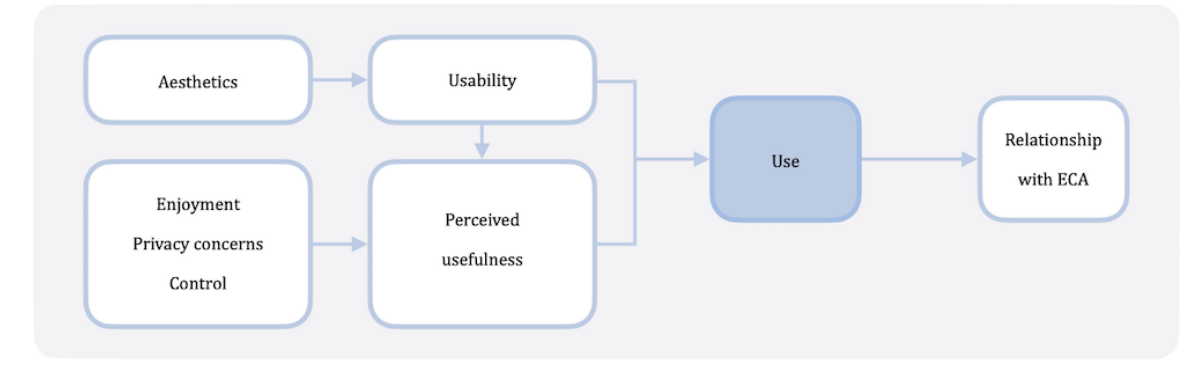
Figure 1. Conceptual model explaining embodied conversational agents (ECA) use, known as